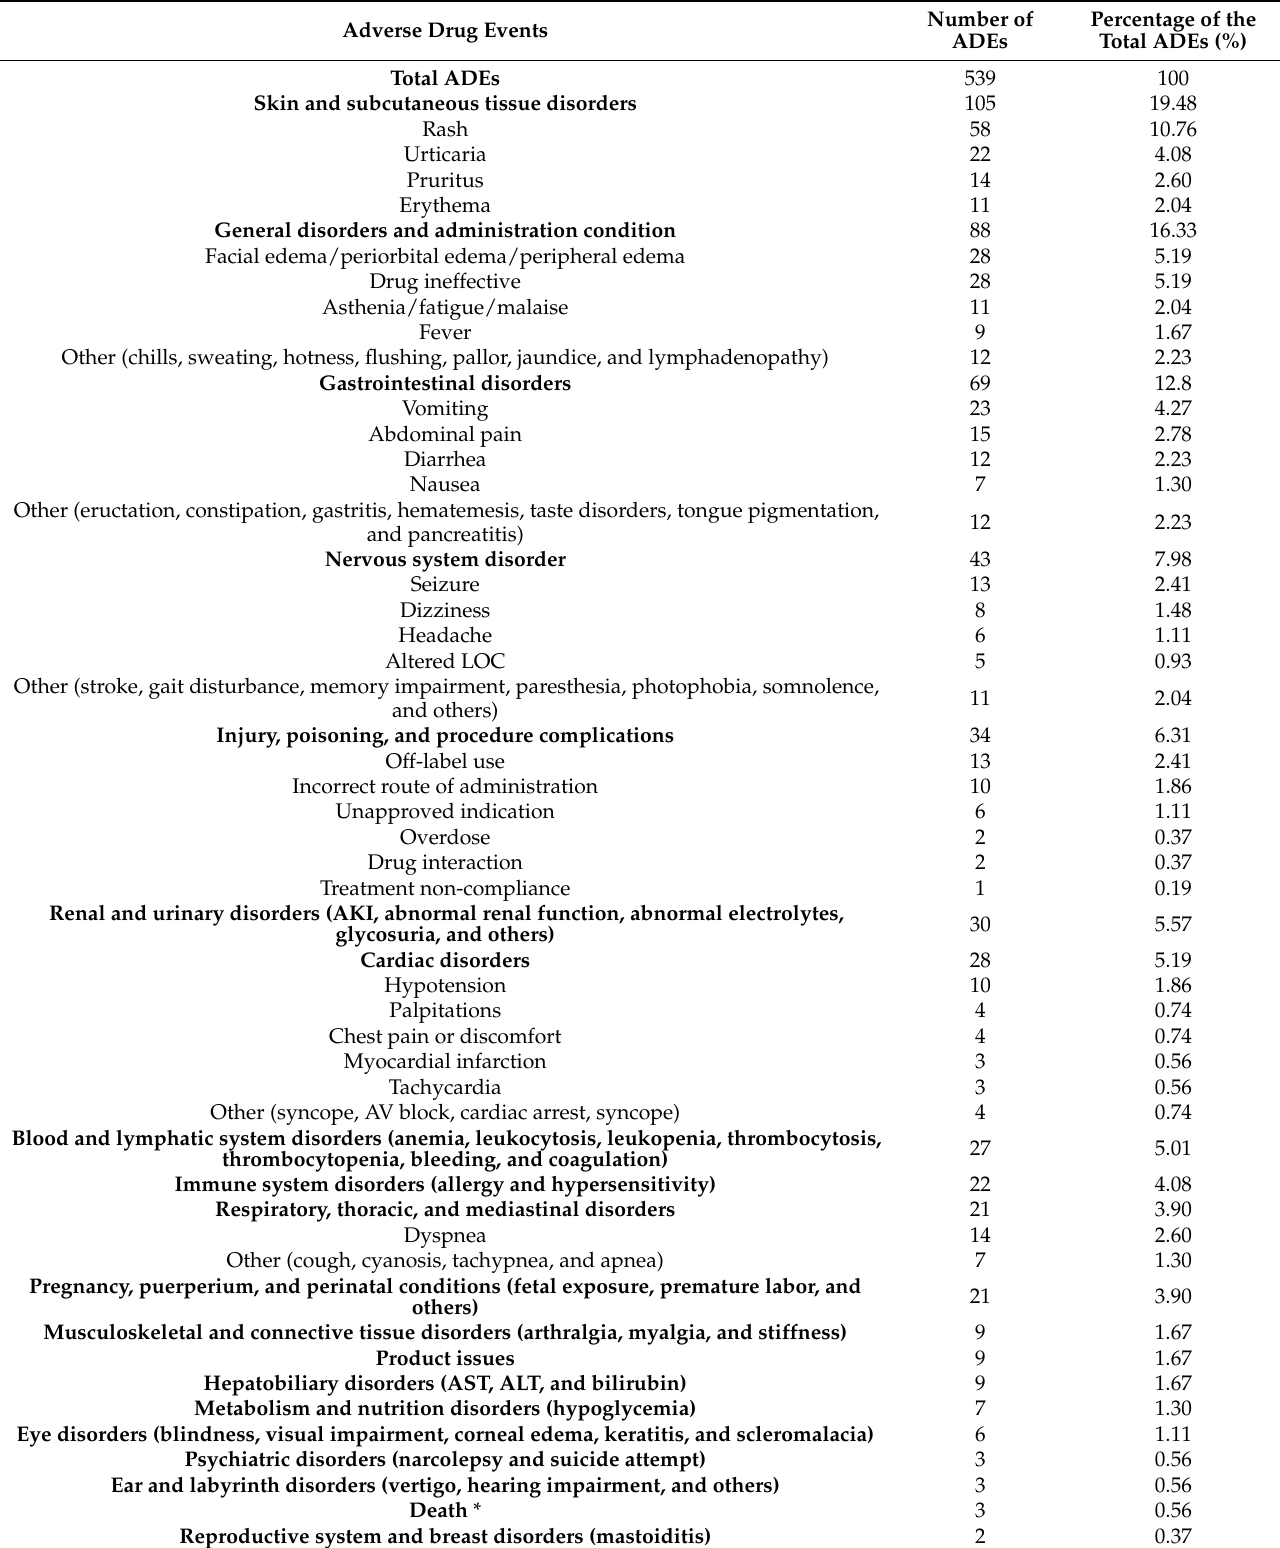
Table 4. Types of antimicrobial-related ADEs in individuals ( n = 279), according to the MedDRA system organ classification reported by the VigiBase in Jordan during